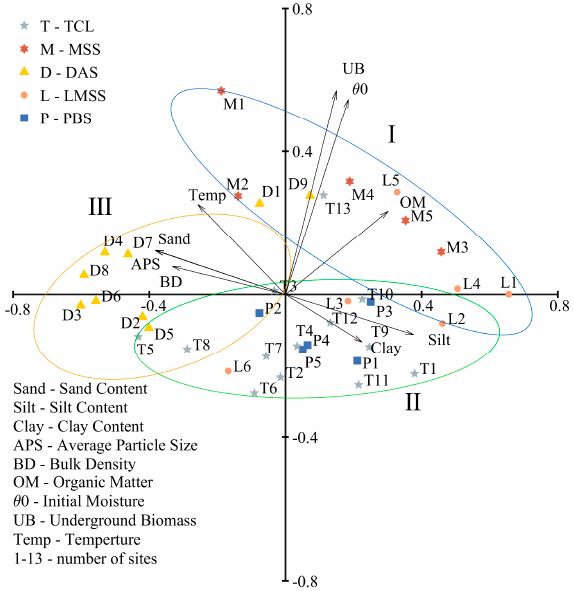
Figure 9. Principal component analysis (PCA) ordination with plotted soil and environmental variables.